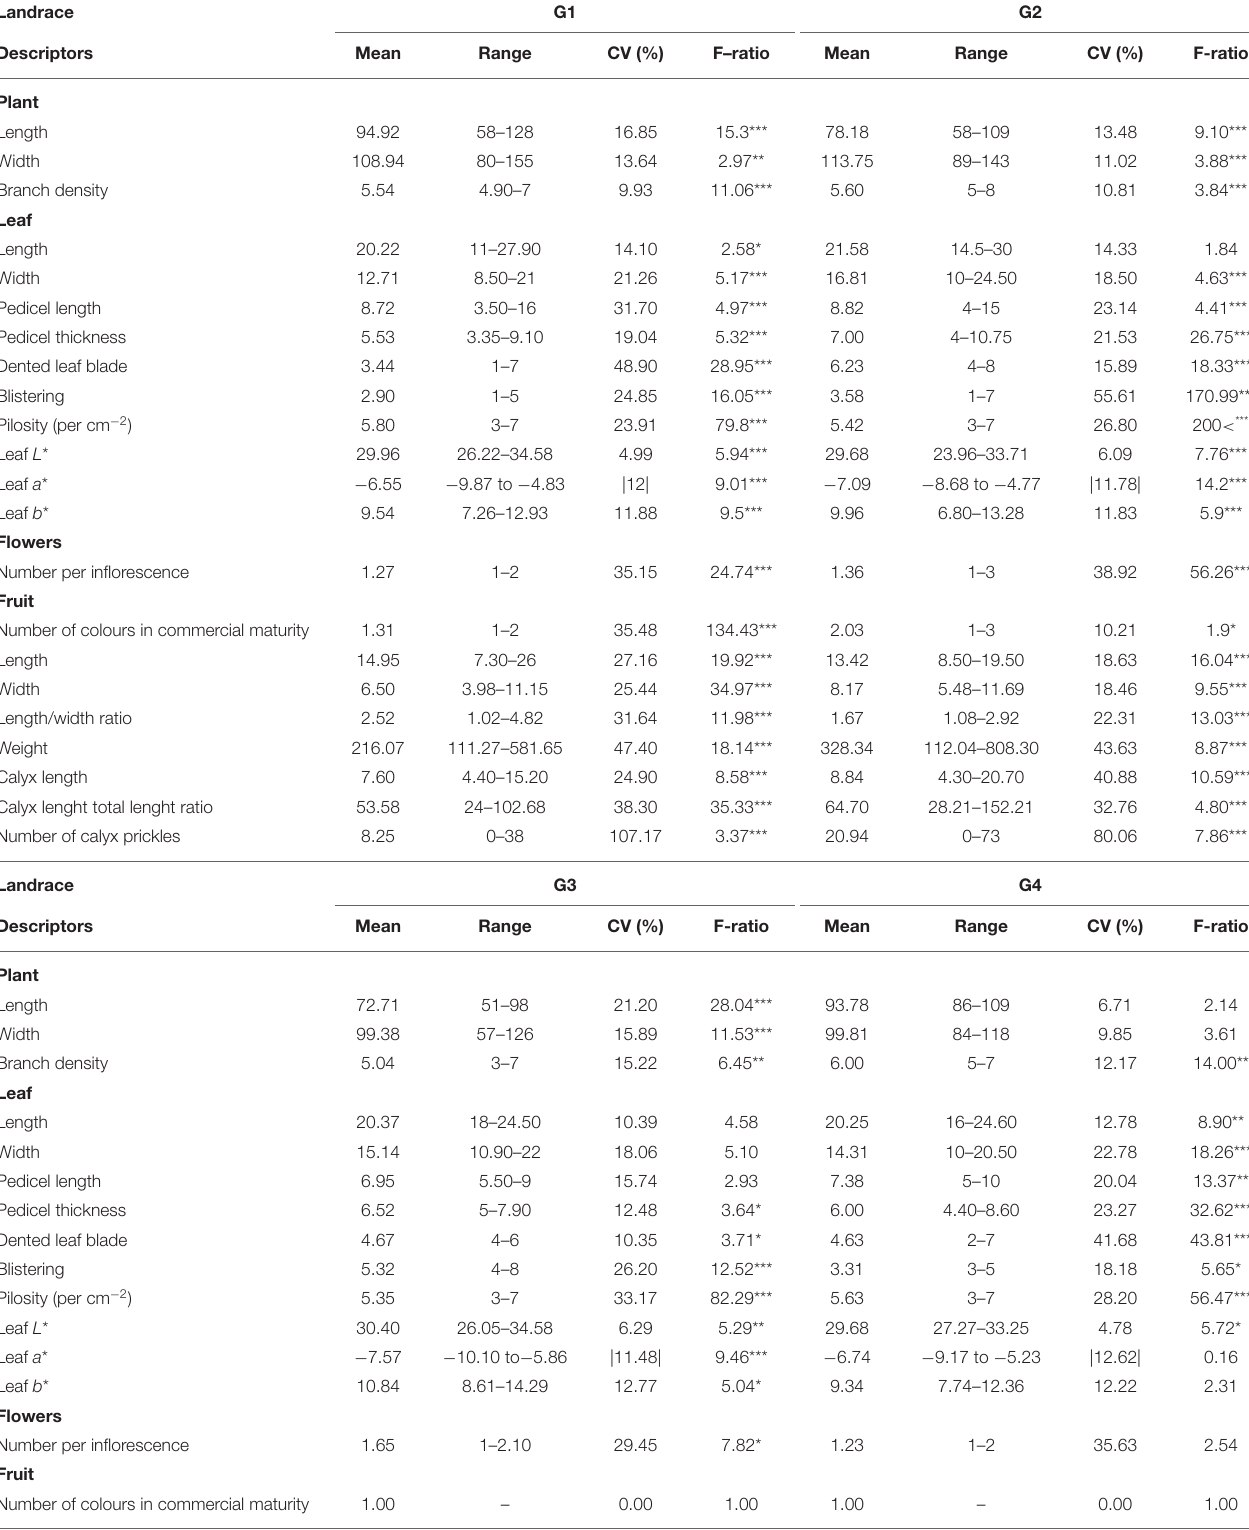
TABLE 4 | Variation parameters for the conventional morphologic quantitative descriptors in the 31 local eggplant landraces cultivated in Spain. Statistics were performed by the formed groups based on fruit skin colour; G1 = black–purple, G2 = striped, G3 = white, G4 = reddish